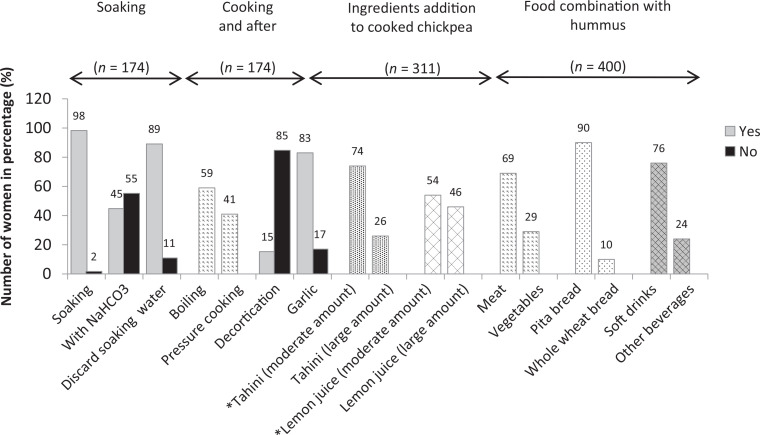
Preparation of hummus and combination with food and beverage among the studied sample (N = 400), Lebanon 2018. Soaking and cooking steps are reported by the women who prepare hummus traditionally (n = 174). Ingredient addition is reported by all the women who prepare hummus (n = 311). Food combination with hummus for consumption is reported by all the women (N = 400).*The amounts of tahini and lemon juice are evaluated in comparison with a traditional Lebanese recipe of hummus (47).